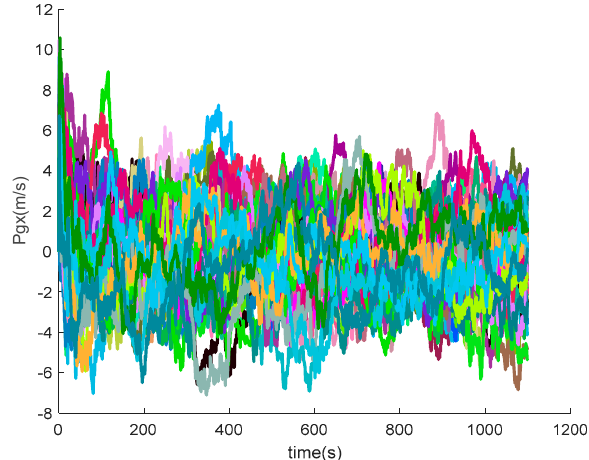
Figure 22. The x -axis position errors of SINS/GPS in the LCEF frame.